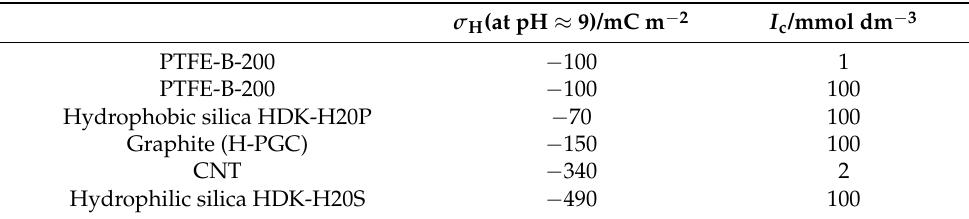
Table 1. Proton-related surface charge densities at pH 9 obtained in the potentiometric acid–base titrations on the hydrophobic and hydrophilic materials.